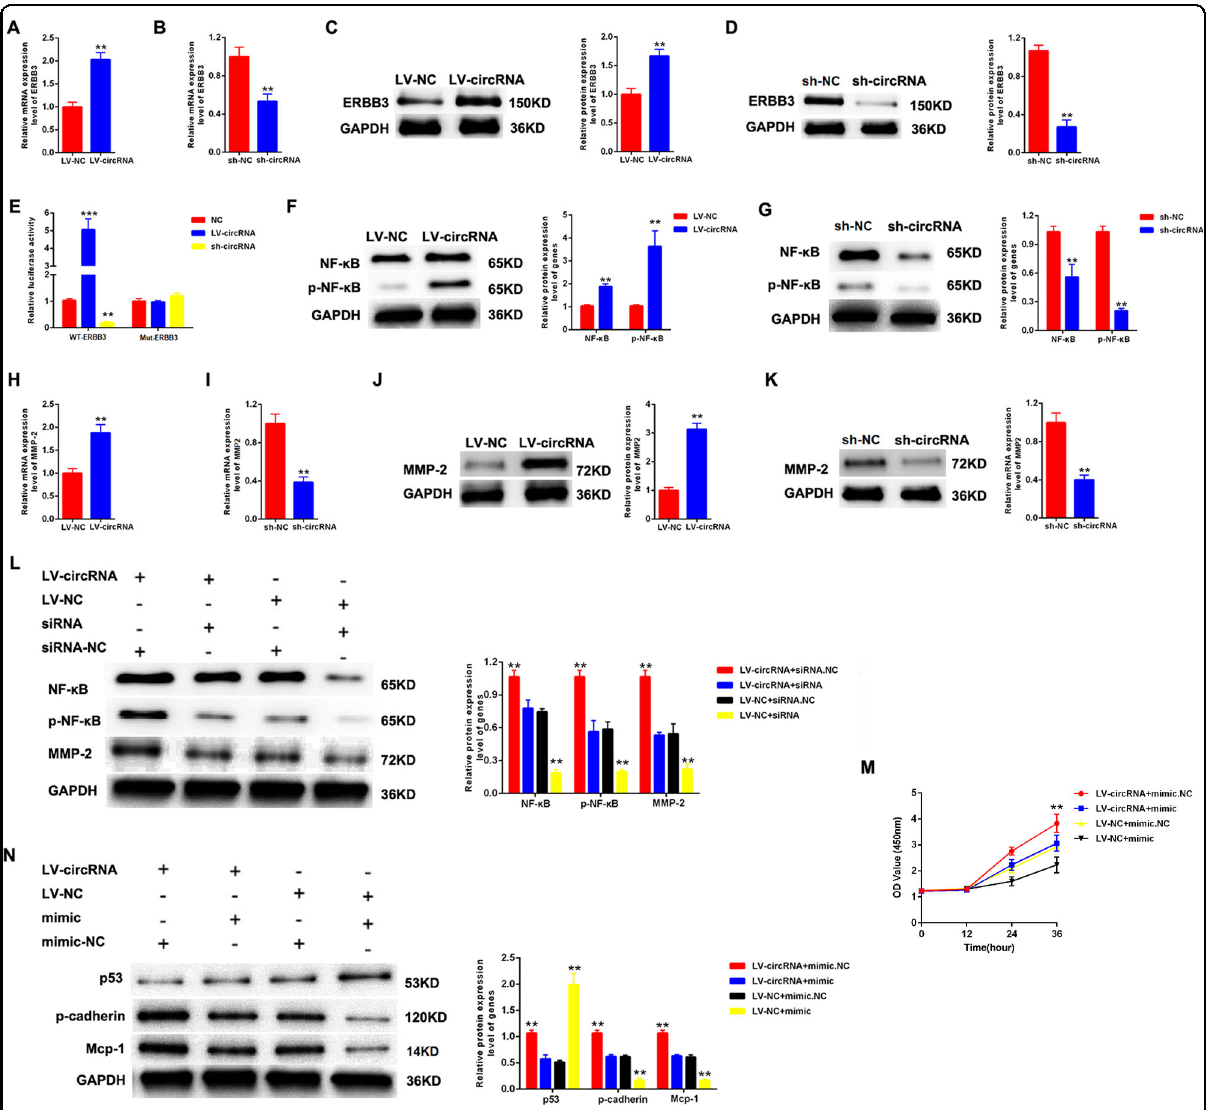
Fig. 5 circ_DLGAP4 promoted proliferation and fi brosis of MCs by regulating ERBB3/p-NF- κ B/MMP-2 axis and sponging miR-143. A , B The mRNA expression level of ERBB3 in MCs infected with LV-circ_DLGAP4 or sh-circ_DLGAP4. C , D The protein expression level of ERBB3 in MCs infected with LV-circ_DLGAP4 or sh-circ_DLGAP4. E The mutant-type reporter gene (Mut-DLGAP4 reporter) and wild-type reporter gene (Wt-DLGAP4 reporter) were established. MCs were co-transfected with LV-circ_DLGAP4 or sh-circ_DLGAP4 with Mut-DLGAP4 reporter or Wt-DLGAP4 reporter. F , G The expression level of NF- κ B/p-NF- κ B was measured by western blotting assay. MCs were transfected by LV-circ_DLGAP4 or sh-circ_DLGAP4. H , I The mRNA expression level of MMP-2 in MCs. J , K The protein expression level of MMP-2 in MCs. L The expression level of p-NF- κ B and MMP-2 in MCs treated with LV-circ_DLGAP4 or ERBB3 siRNA. M Proliferation of MCs transfected with LV-circ_DLGAP4 or mimic-miR-143. N The protein expression level of p-53, p-cadherin, and Mcp-1 in MCs treated with LV-circ_DLGAP4 or mimic-miR-143. Three independent experiments were conducted. Error bars stand for the mean ± SD of at least triplicate experiments; ** P < 0.01, *** P <